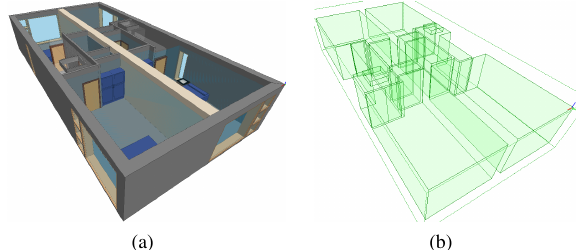
Figure 1: Original IfcSpaces in an IFC model. (a) One building storey. (b) Corresponding IfcSpaces .